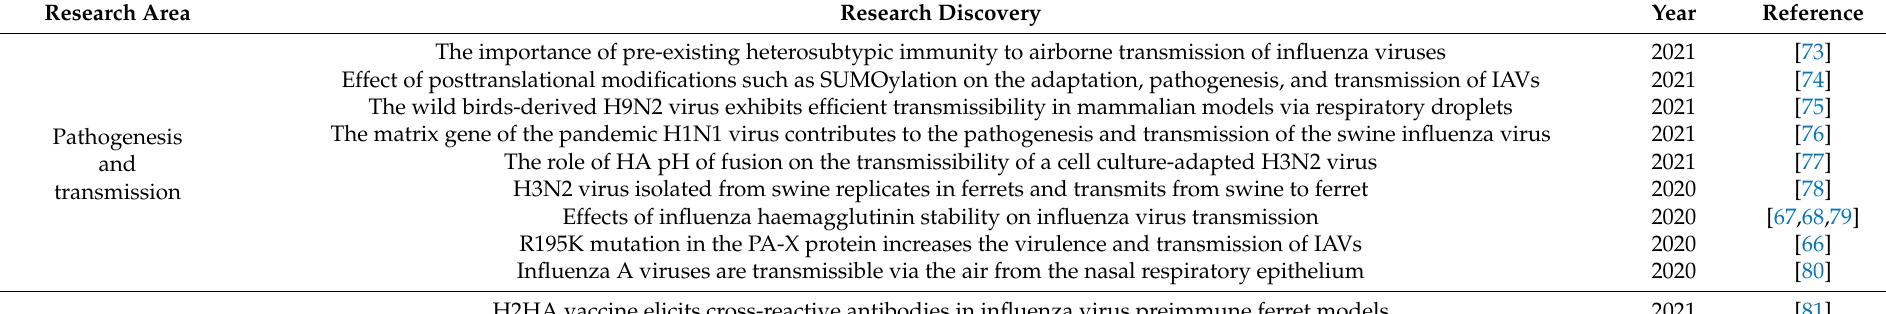
Table 2. Summary of some discoveries in influenza virus research using the ferret model in